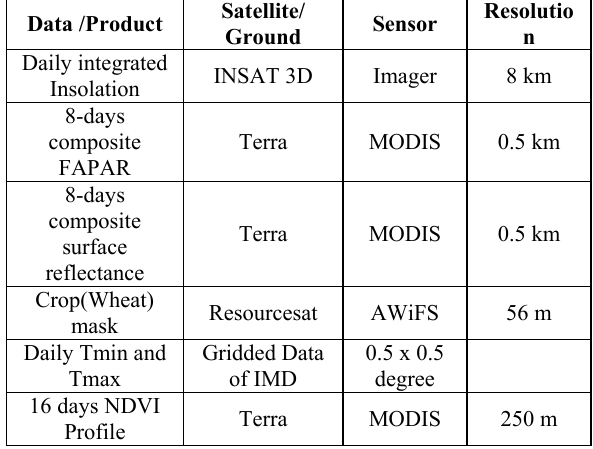
Table 2. Showing satellite details for Yield